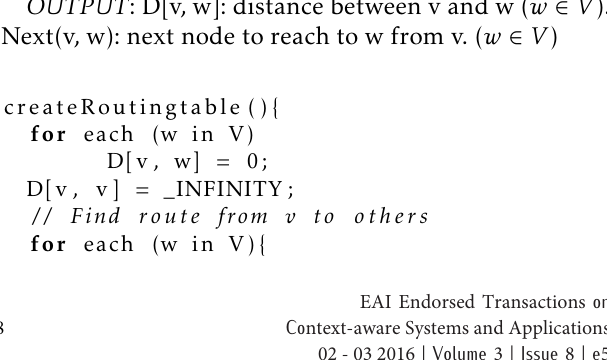
ALGORITHM : Calculate a routing table for node v